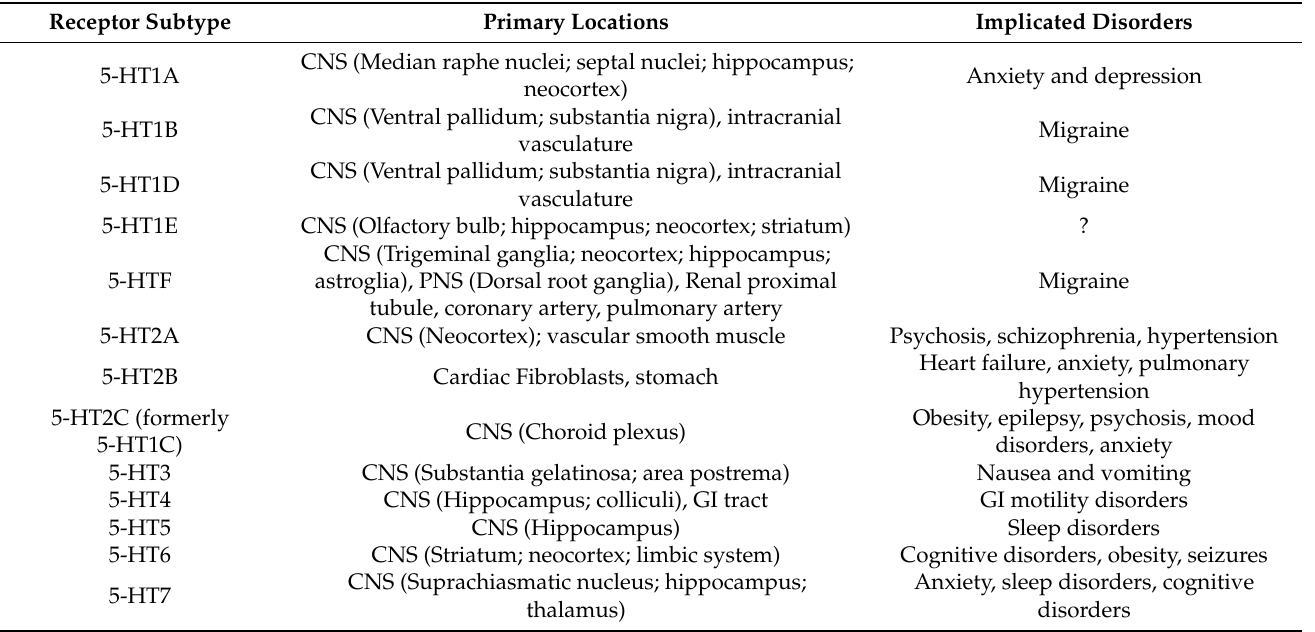
Table 1. Serotonin Receptor Subtypes. Serotonin receptors vary in expression in target tissues and are implicated in a variety of disorders